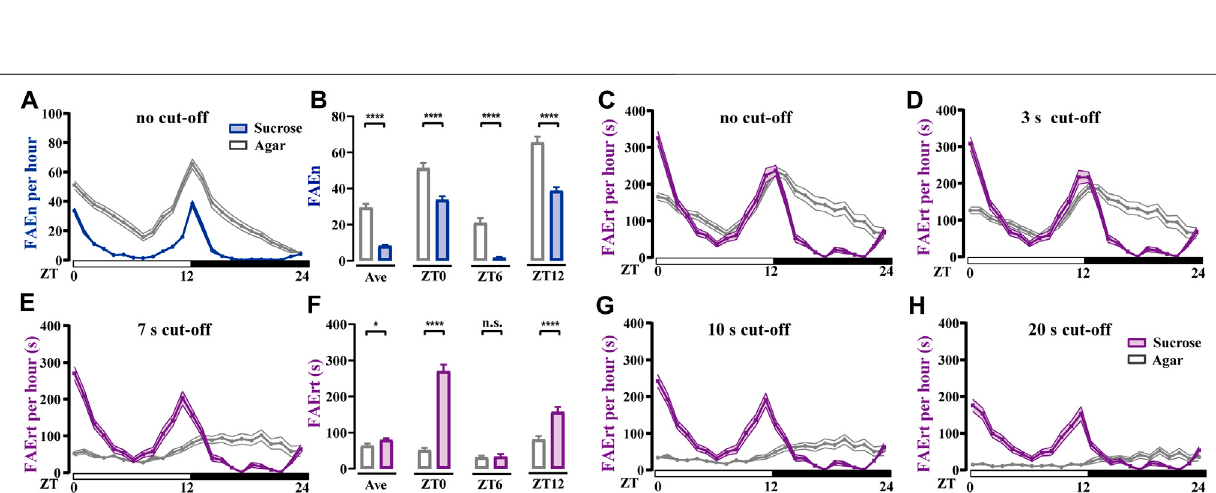
FIGURE 3 | FAE exhibits similar distributions of feeding and no-feeding behaviors at different time-points of the day (A – E) The proportion distribution of FAE at ZT0 – 1 ( n (cid:1) 202), ZT4 – 5 ( n (cid:1) 189), ZT7 – 8 ( n (cid:1) 213), ZT10 – 11 ( n (cid:1) 242), and ZT12 – 13 ( n (cid:1) 339) (F – G) With the cut-off threshold of 7 s, the proportion of retained and eliminated FAEn (F) and FAErt (G) at different times of the day. Data are shown for both sexes, with a total of 1,185 events and a total time of 8,603 s used for analysis.